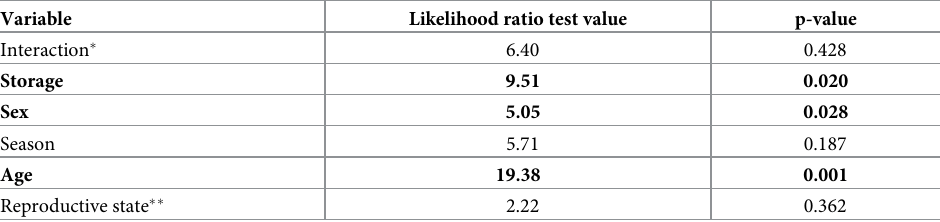
Table 1. Significance of model terms calculated using parametric bootstrapped likelihood ratio tests.